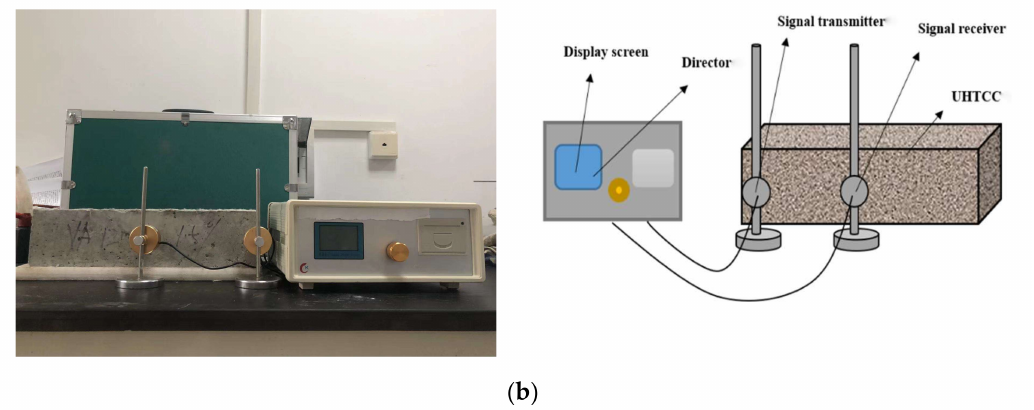
Figure 2. Schematic diagram of the test equipment: ( a ) freeze–thaw cycle test; ( b ) dynamic elastic modulus